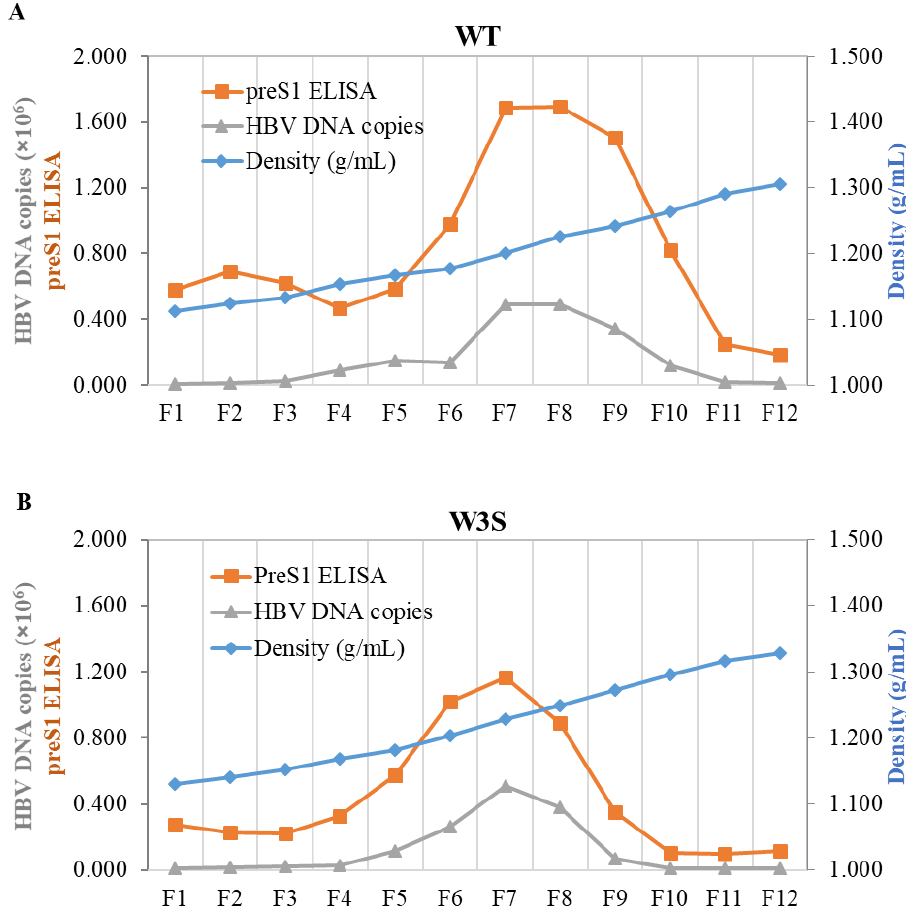
Figure 3. Analysis of the HBs and Dane particle formation pattern. HepG2 cells were transfected with the wild-type and mutant HBV-producing plasmids. The media were collected at 7 days post-transfection, PEG-precipitated, and subjected to CsCl density gradient centrifugation. Density, preS1 ELISA and qPCR analyses were carried out from a total of 12 collected fractions. ( A ) HBs and Dane particle formation pattern of wild-type HBV. ( B ) HBs and Dane particle formation of the massively glycosylated mutant HBV (W3S).